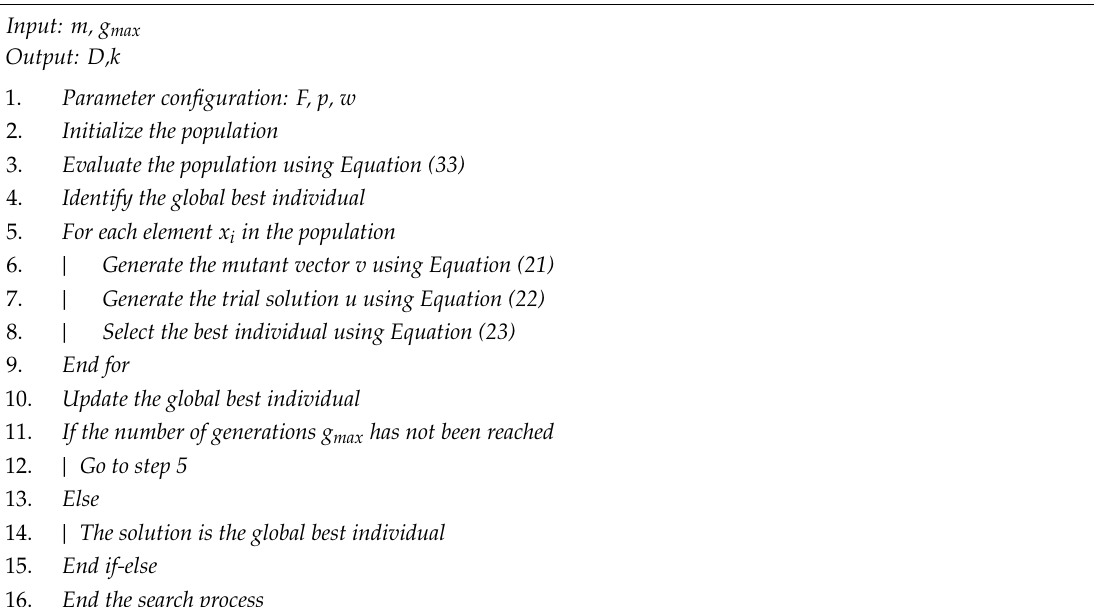
Algorithm 1. Optimization